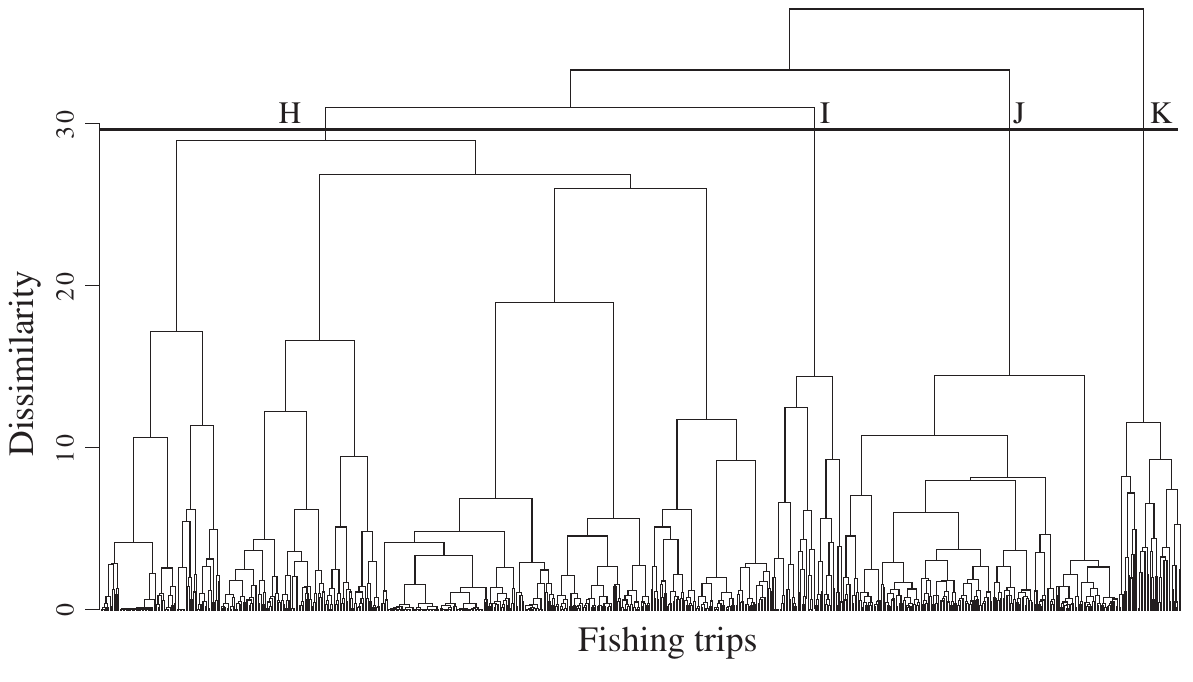
Fig . 7. – Dendrogram of the boat seine fishing trips in the ionian Sea, based on the log-transformed landings